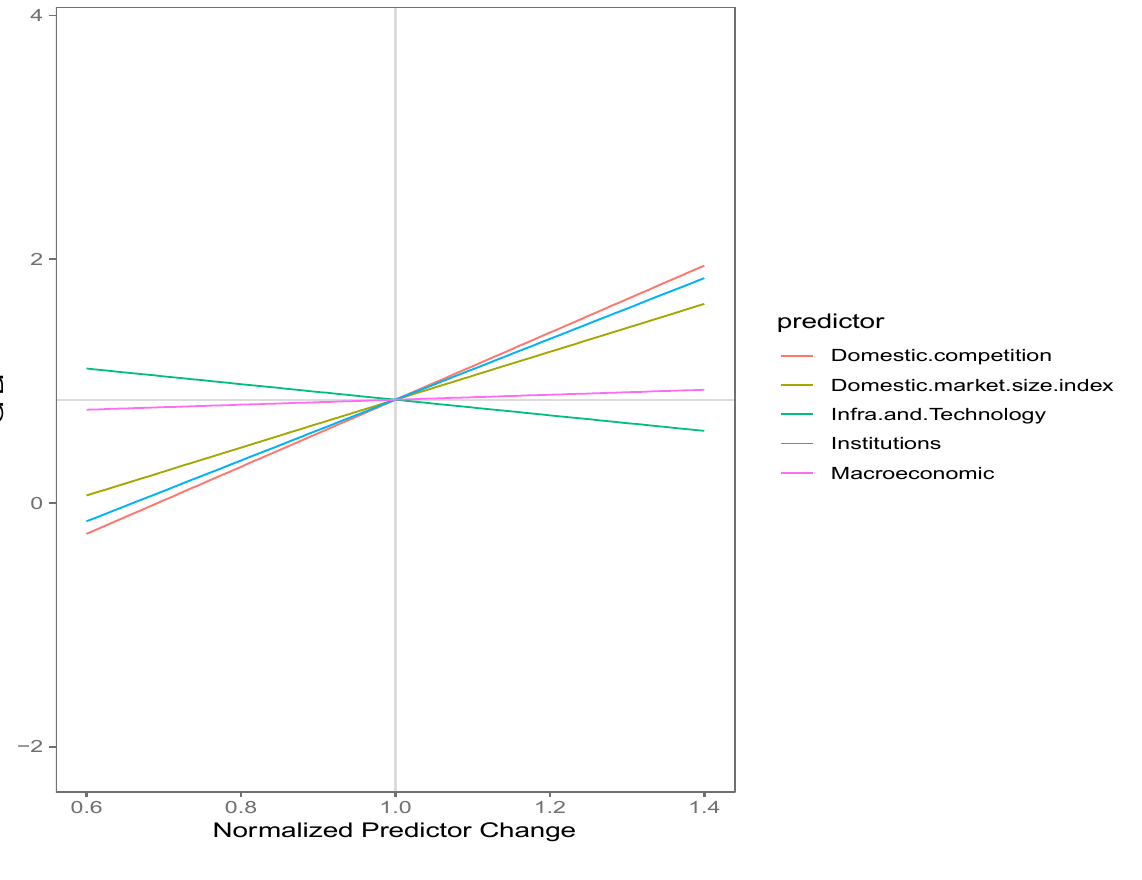
Figure 6. Sensitivity analysis for model (2) with a 90% confidence interval constructed for each